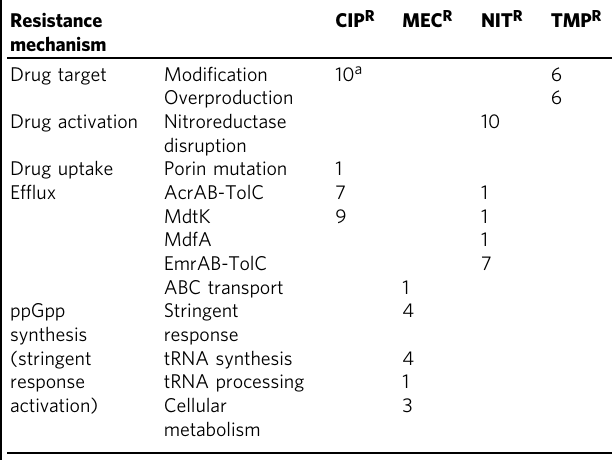
Table 3 The number of antimicrobial resistant mutants with resistance-associated mutations Resistance